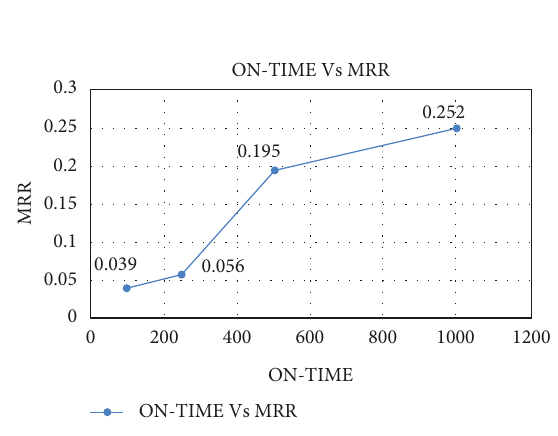
Figure 9: Tool diameter versus tool wear rate.